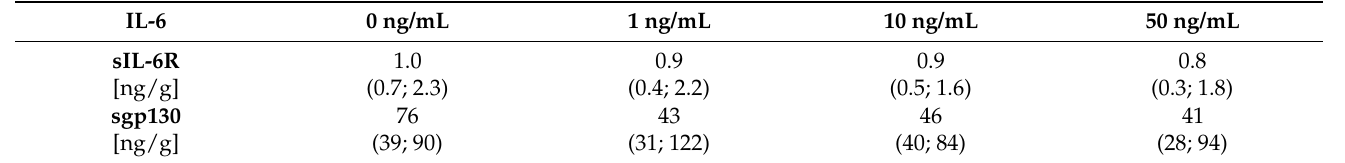
Table 2. Concentrations of soluble IL-6 receptor (sIL-6R) and soluble gp130 (sgp130) secreted by human osteoblasts (passage 3) after a 72 h stimulation with different concentrations of IL-6 ( n = 5 independent donors (female: n = 4, male: n = 1); mean age: 77.8 ± 4.4 year). Protein contents were analyzed via ELISA and related to total protein in the cell culture supernatants. All results are shown as median and minimum/maximum